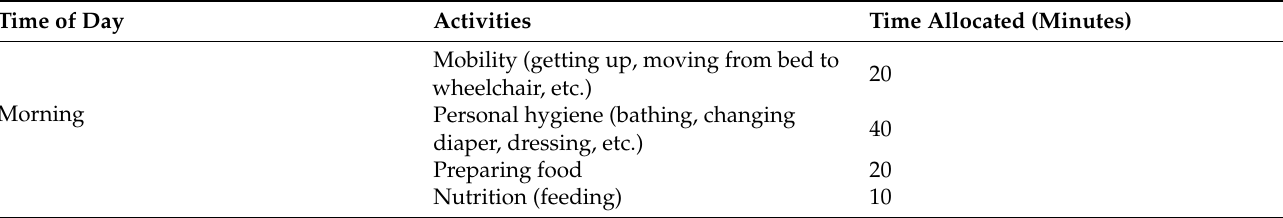
Table 1. Shirin’s working